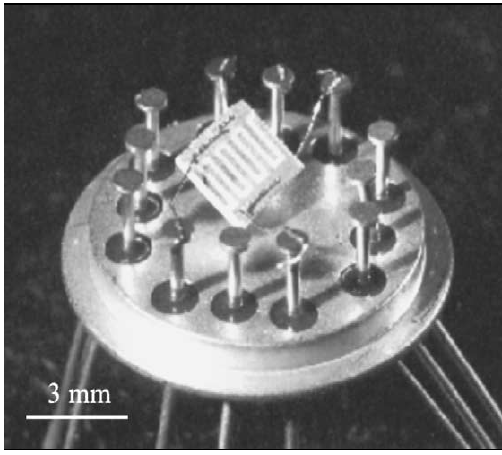
Figure 11 . Sensing elements fixed on wired